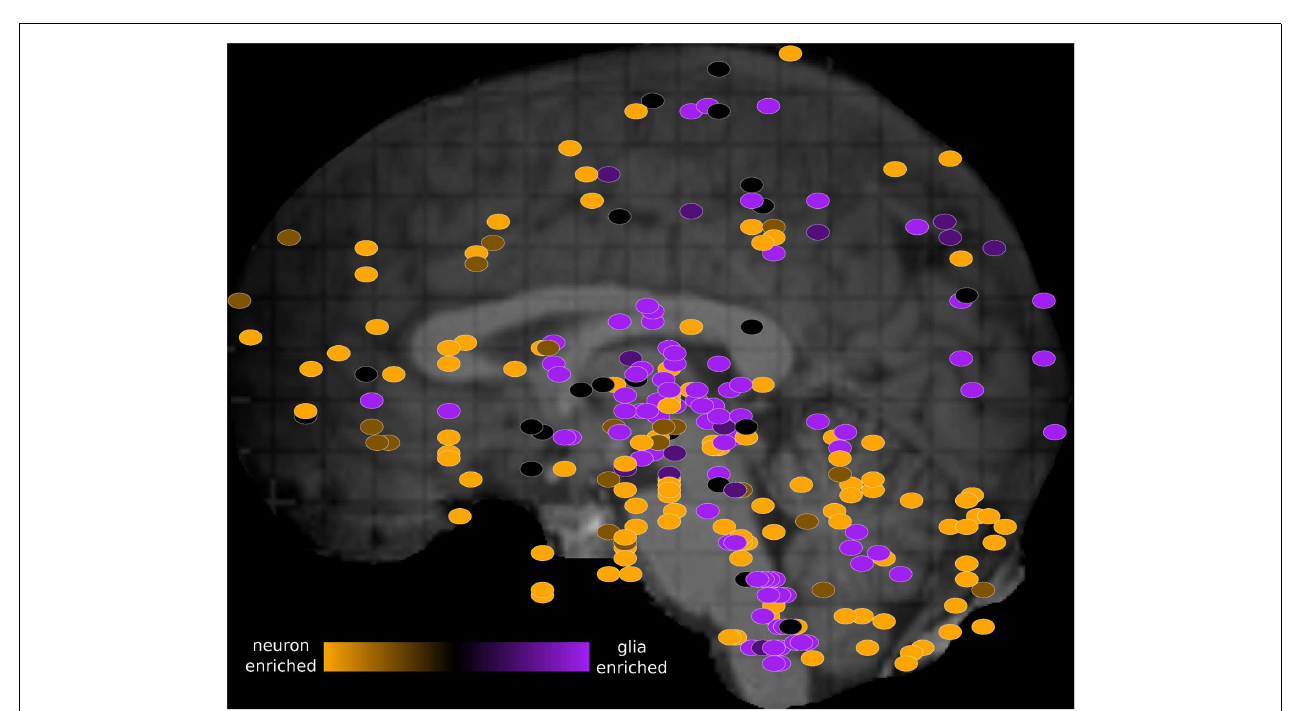
respectively.These dots were manually overlaid onto a brain image from the Allen Brain Explorer 2 software (http://mouse.brain-map.org/static/ brainexplorer). In order to visualize subcortical region samples, we have hidden the visualization of the left cerebral hemisphere which causes some cortical samples (such as part of the left temporal cortex) to appear outside of the brain.